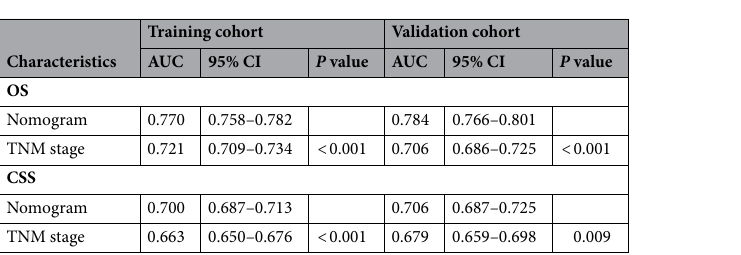
Figure 2. Nomogram predicting 3-, and 5-year overall survival (OS) and cancer-specific survival (CSS) rate of GCC patients. ( A ) OS rate; ( B ) CSS rate.